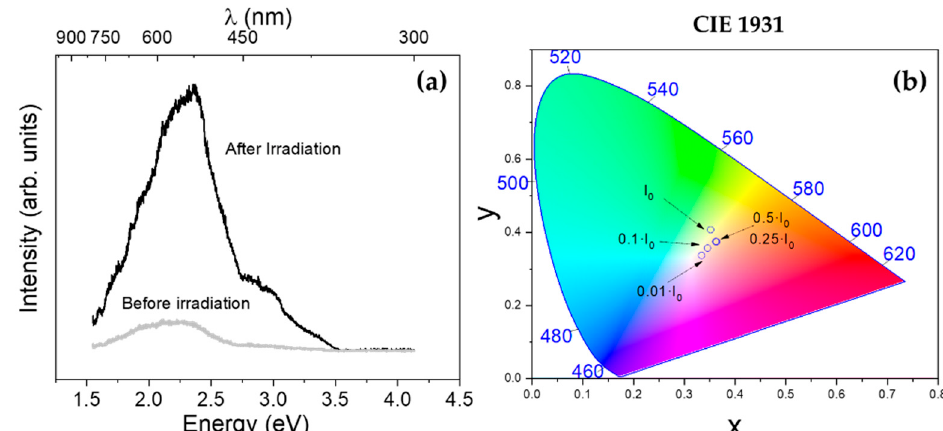
Figure 6. ( a ) PL of SnO nanoparticles before irradiation (acquired with a 0.1 · I 0 neutral filter) and after irradiation with I 0 for 10 s (acquired with a 0.1 · I 0 neutral filter). ( b ) Comission Internationale de l’Eclairage (CIE) 1931 plot corresponding to PL intensity of SnO nanoparticles using different neutral filters.